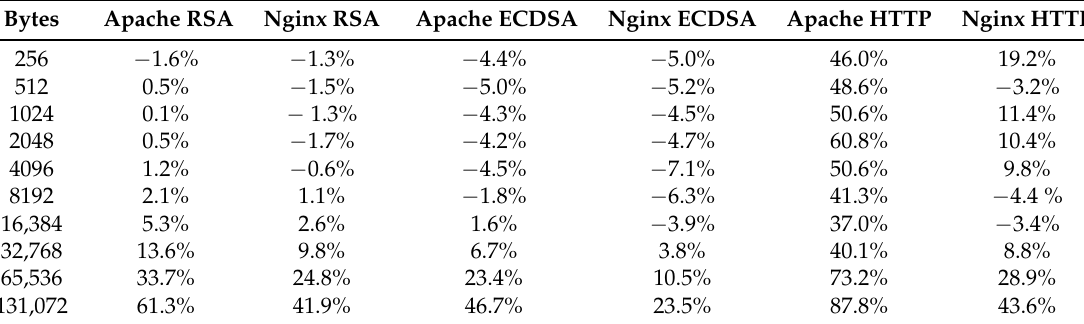
Table 4. Client-side page size versus energy consumption difference (in percentage) between GNU ZIP (GZIP) compression and no compression for Apache2 and Nginx with 16 concurrent clients.